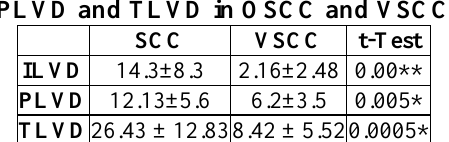
Table 3: Mean labeling index of the ILVD, PLVD and TLVD in OSCC and VSCC